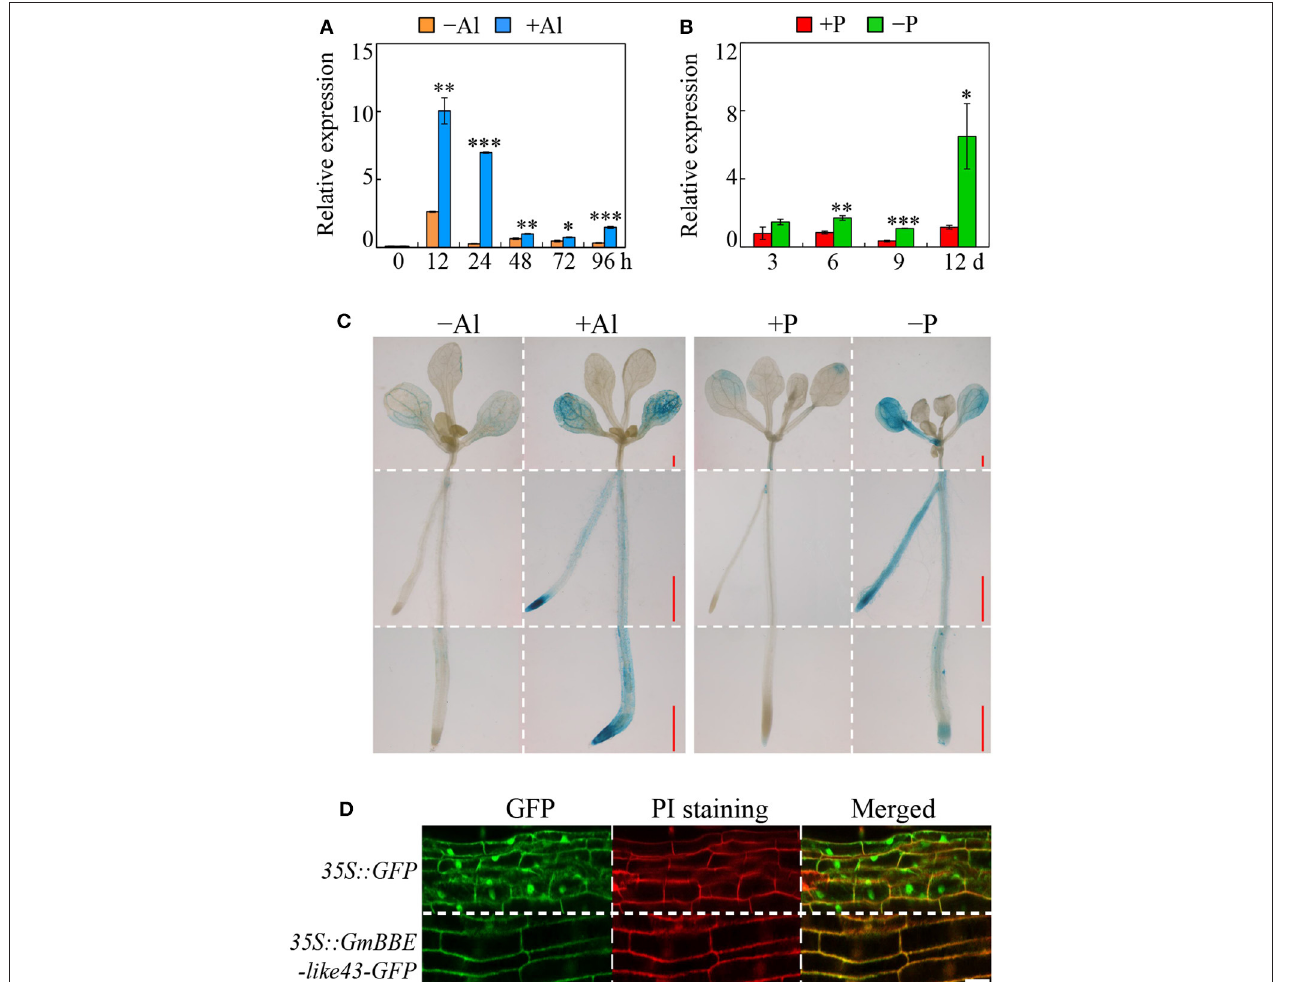
FIGURE 2 | Expression analysis of GmBBE-like43 and its subcellular localization. (A) Relative expression of GmBBE-like43 in 0-2cm soybean root tips in response to Al for different time periods; (B) Relative expression of GmBBE-like43 in response to Pi starvation at the indicated times; (C) Transgenic Arabidopsis containing the pGmBBE-like43 :: GUS and 35S::GUS were subjected to either Al treatment (0 µ M or 5 µ M AlCl 3 ) for 24h or P treatment (1.25mM and 6.25 µ M KH 2 PO 4 ) for 6 d. Bars = 0.5mm; (D) Subcellular localization analysis of GmBBE-like43 in common bean hairy roots. Red fluorescences were derived from PI indicating the cell wall. Bars = 20 µ m. Asterisks indicate a significant difference between either + Al and –Al treatments or –P and + P treatments according to Student’s t -test: * : P < 0.05; ** : 0.001 < P < 0.01; *** : P <